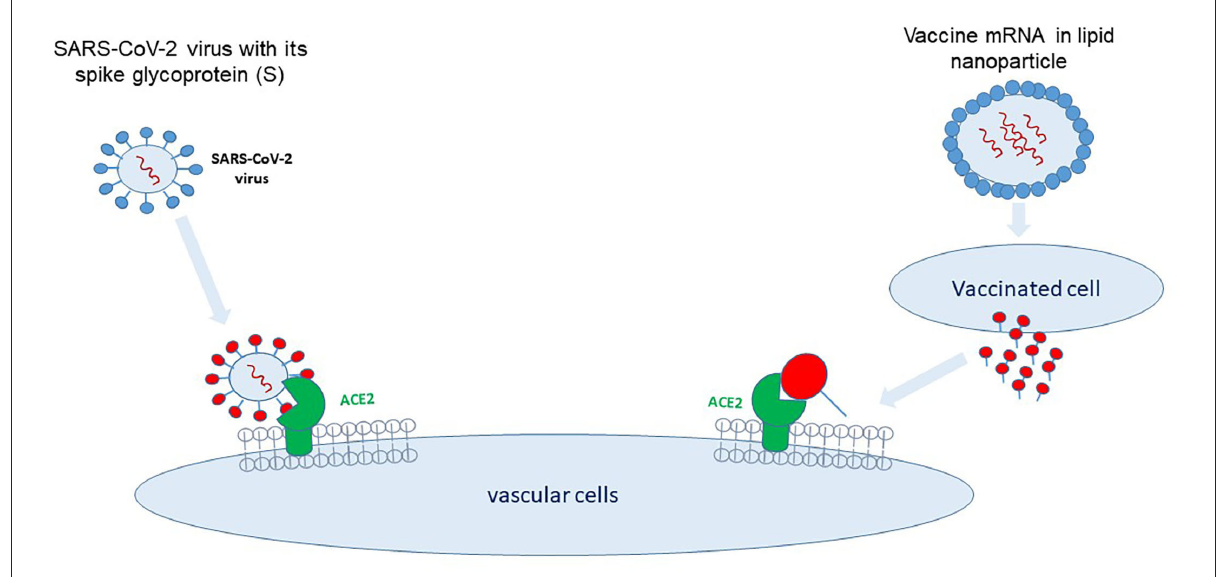
FIGURE1 Two sides of the same evil. SARS-CoV-2 binds via its spike protein to the angiotensin-converting enzyme (ACE)2-receptor located on multiple cell types, i.e., vascular endothelial cells, immune cells, and pulmonary epithelial cells. mRNA vaccines encode for the SARS-CoV-2 spike protein which is synthesized and released by the transfected cells and binds to cells carrying the